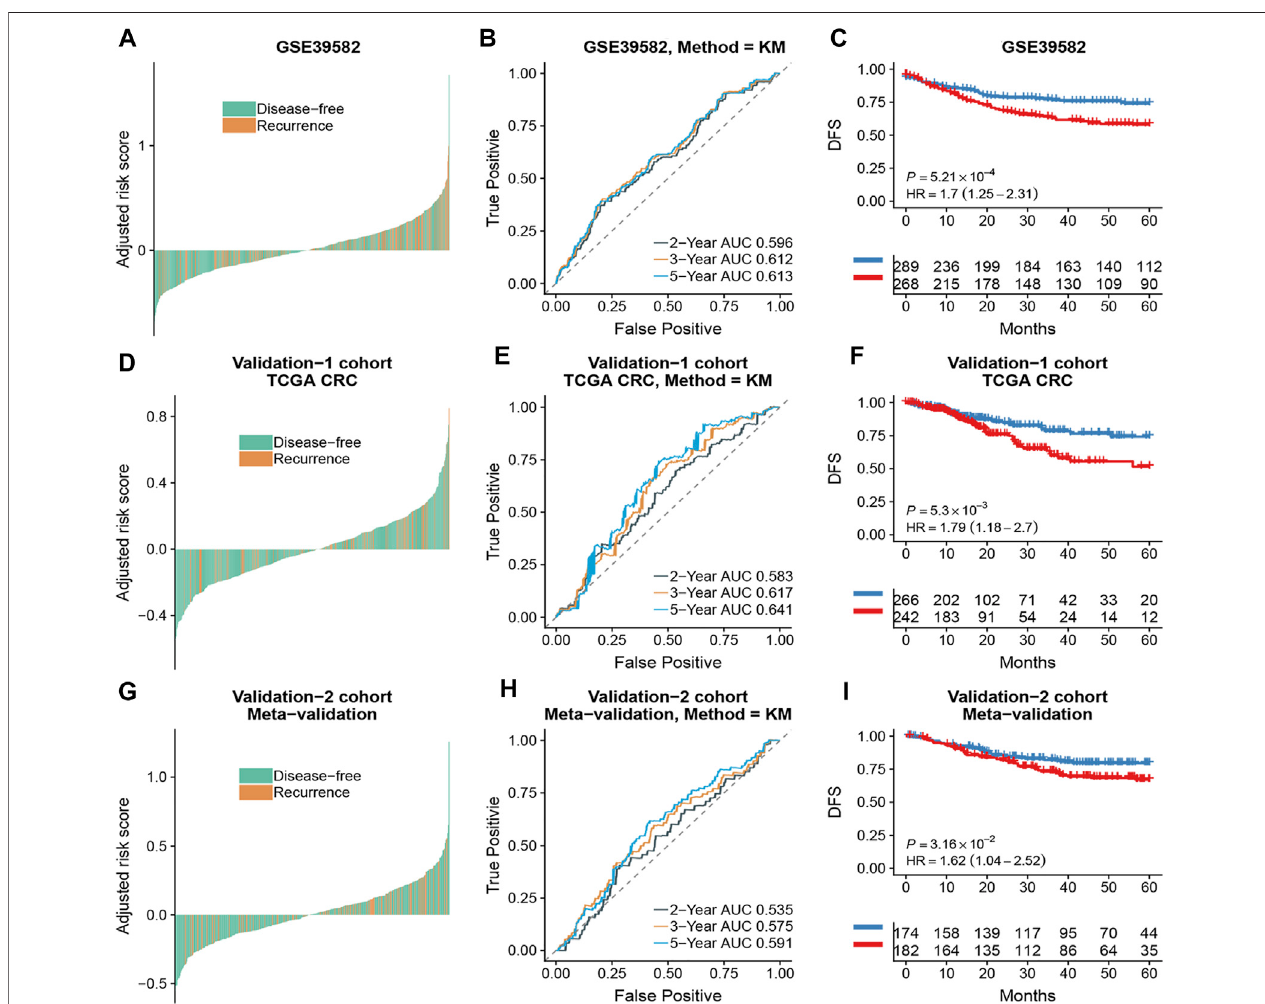
FIGURE 5 | The association of the ATG signature with DFS in CRC patients with all stages. Patients with CRC of the early stage were ranked by autophagy risk scoresintheGSE39582 cohort (A) ,theTCGA cohort (D) ,andthemeta-validationcohort (G) .Time-dependentROCcurves forDFSinCRCpatientswereachievedwith different durations in the GSE39582 cohort (B) , the TCGA cohort (E) , and the meta-validation cohort (H) . Kaplan – Meier curvesshowed DFS ofCRC patients in low and highautophagygroupsintheGSE39582cohort (C) ,TCGAcohort (F) ,andmeta-validationcohort (I) ,respectively. p valuescomparingriskgroupswerecalculated with the log-rank test. Hazard ratios (HRs) and 95% CIs are for low vs. high autophagy risk. CRC, colorectal cancer; ATG, autophagy-related gene; DFS, disease-free survival.